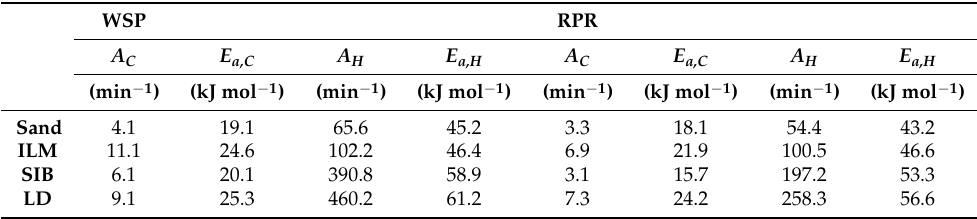
Table 2. Pre-exponential factors and activation energies calculated from devolatilization data according to the procedure described in Appendix A.